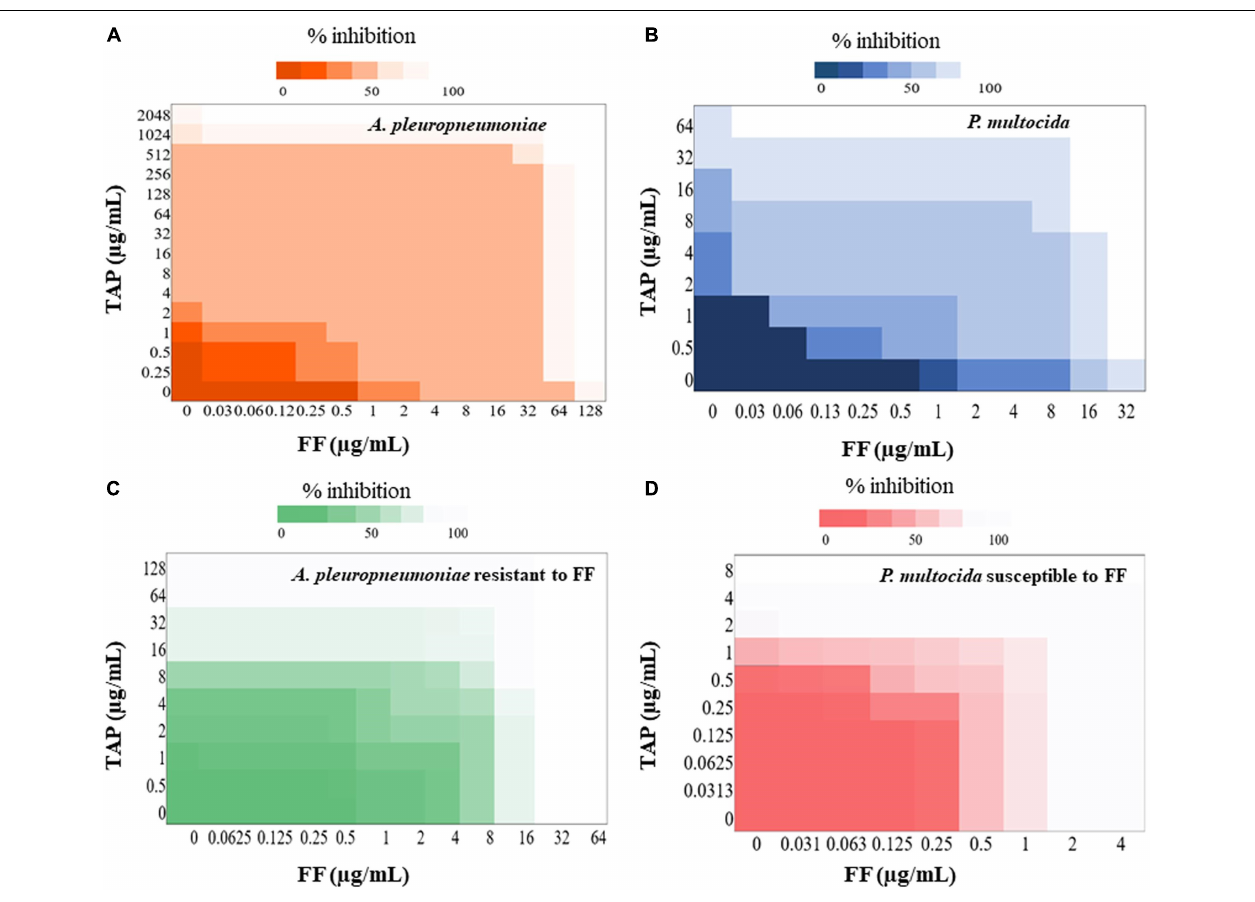
FIGURE 1 | Heat plot showing synergy of FF and TAP. Checkerboard analyses showing the percentage inhibition on the combined effect of FF and TAP against (A) A. pleuropneumoniae (B) P. multocida (C) A. pleuropneumoniae resistant to FF and (D) P. multocida susceptible to